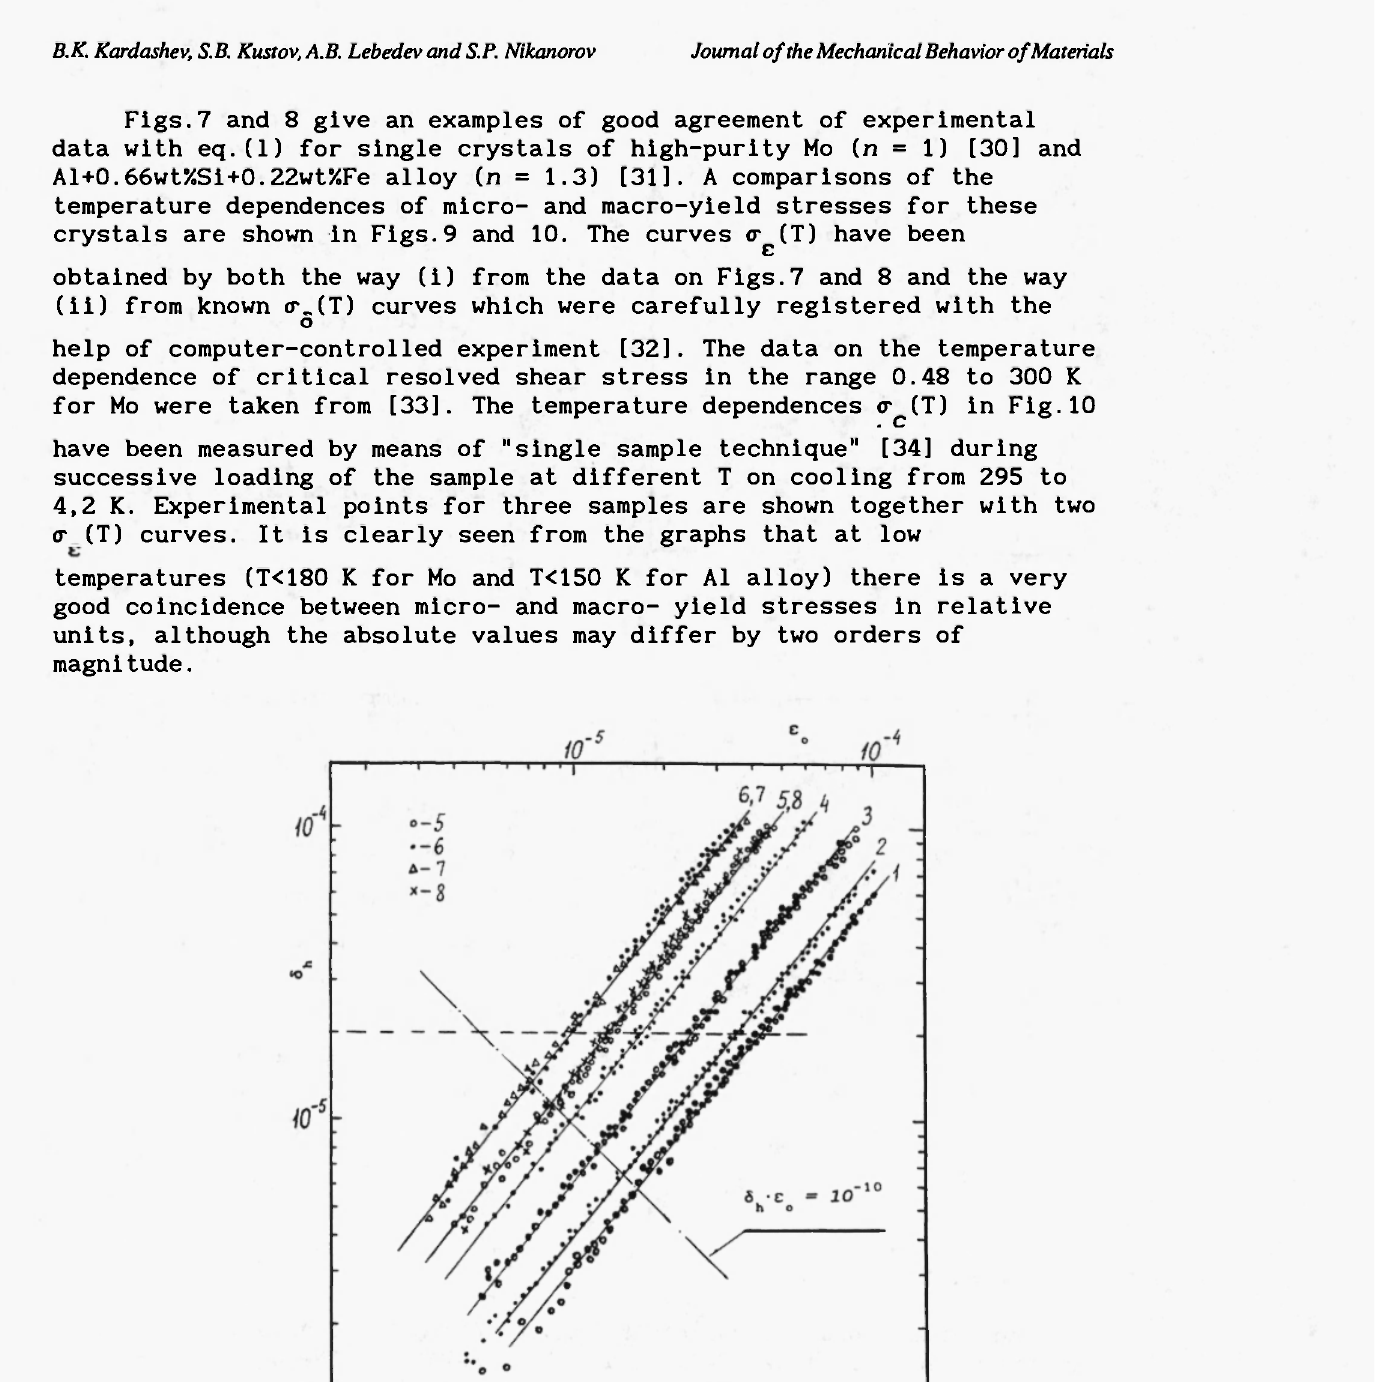
FIG.8 Amplitude-dependent part of decrement in Al+0.66wt%Si+0.22wt%Fe at temperatures: Τ = 6.5 (1), 26 (2), 60 (3), 100 (4), 140 (5), 197 (6), 227 (7) and 247 Κ (8). Solid lines correspond to the function δ <χ ε with η = 1.3 [31].